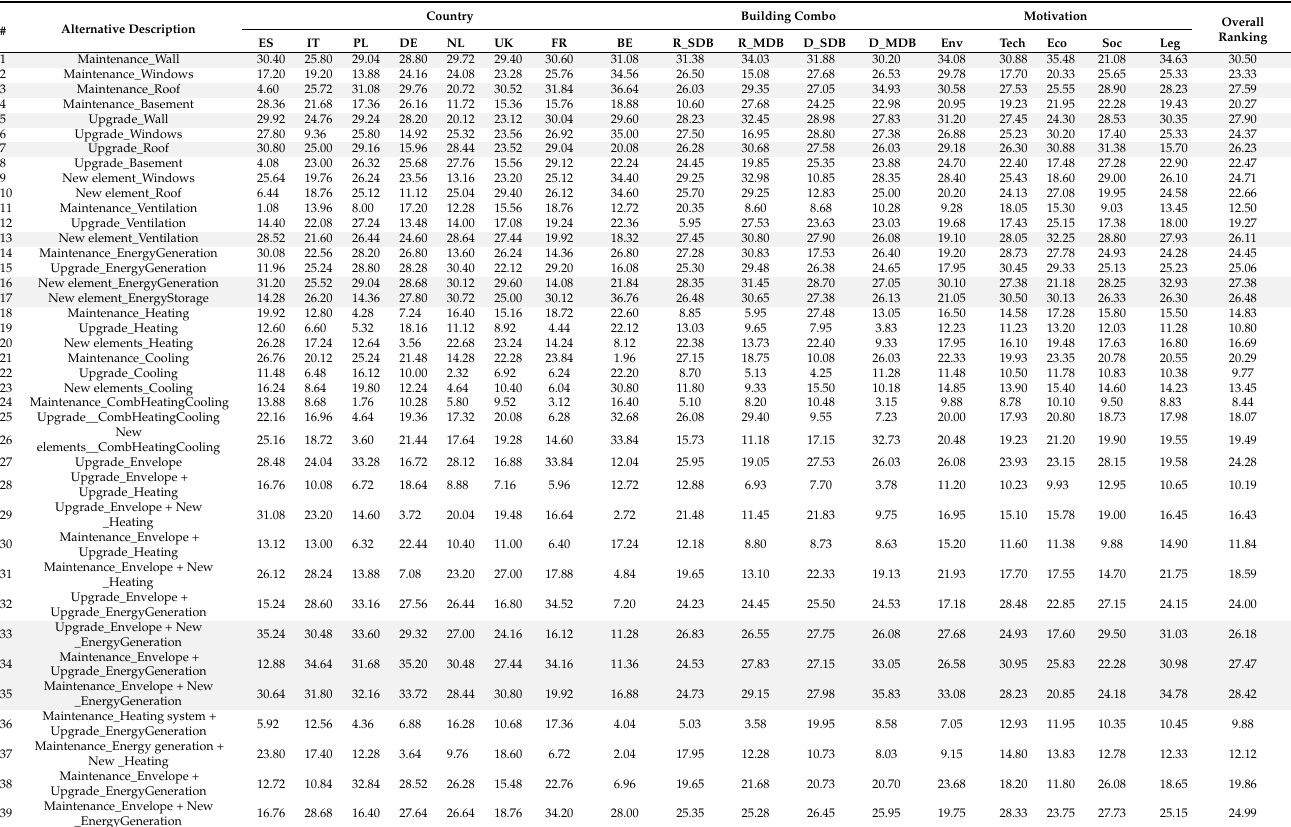
Table 10. Average ranking per alternative across countries, building combo, and